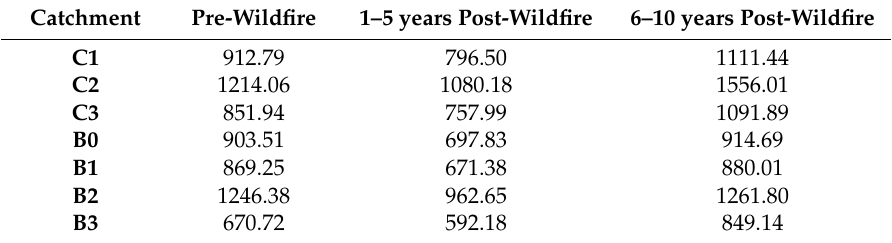
Table 4. Annual rainfall during pre-wildfire, 1–5 years post-wildfire and 6–10 years post-wildfire for all catchments